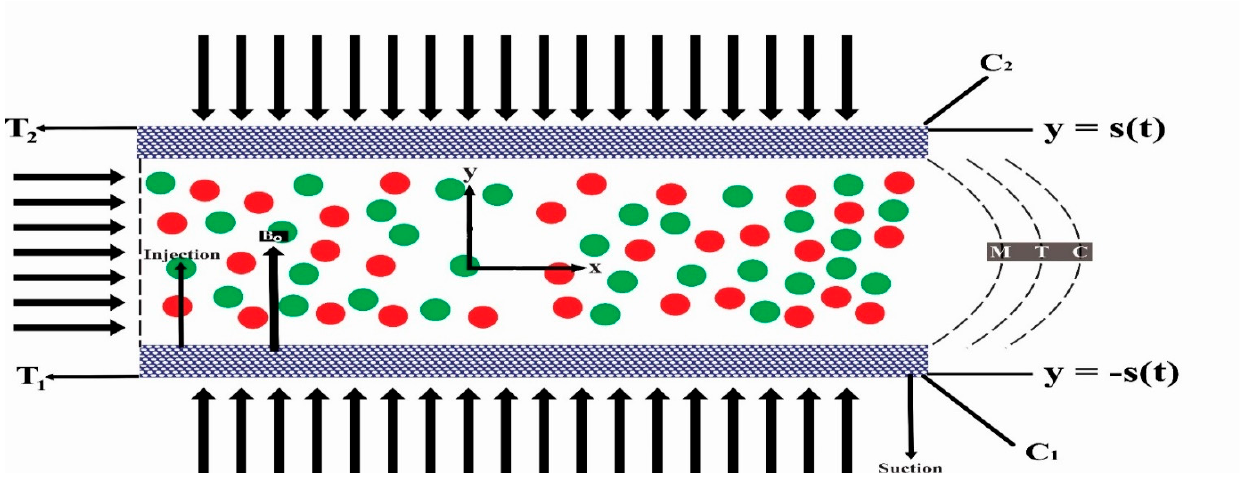
Figure 1: Physical model. Table 1: Thermo-physical properties of hybrid nanofluids [54]. Table 1. Thermo-physical properties of hybrid nanofluids [54].